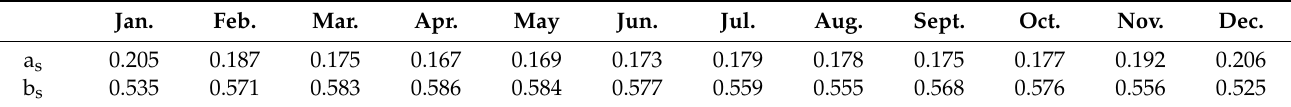
Table 1. Monthly average a s and b s values in China.